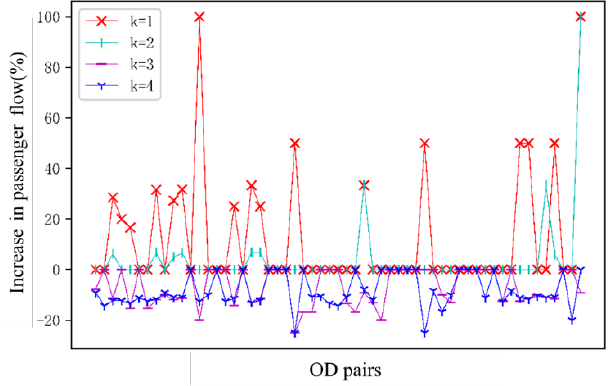
Figure 8. Passenger flow growth of each OD pair.